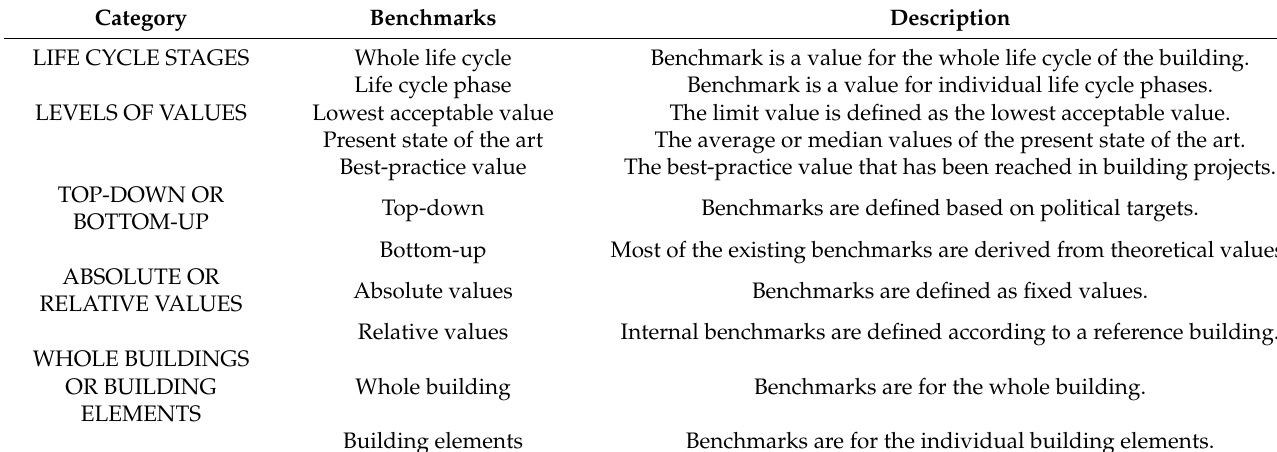
Table 1. Various types of benchmarks of LCA of